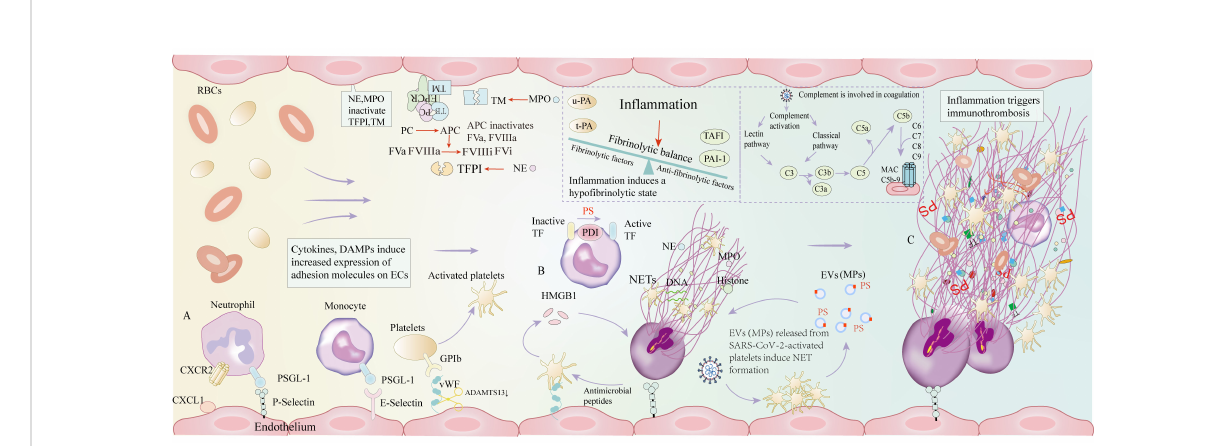
FIGURE 1 The mechanisms of immunothrombosis in COVID-19 patients. (A) In fl ammation induces immune cell recruitment and increased expression of adhesion molecules, including P-selectin, E-selectin, and vWF. (B) Activated platelets activate neutrophils and generate NETs through the release of HMGB1, and the components of NETs, antimicrobial peptides, further induce platelet activation, forming a positive feedback activation. NE and MPO can inactivate TFPI and TM, thereby inhibiting anticoagulant function. Monocytes exert pro-coagulant effects by converting inactive TF to active TF, which is required for PS and PDI. EVs (MPs) are mainly derived from SARS-CoV-2-activated platelets. Platelet-derived EVs (MPs) are responsible for robust NET formation, which plays a critical role in COVID-19 thrombosis. Activated platelets and platelet-derived EVs are markers and central mediators of COVID-19 immunothrombosis. Under in fl ammatory settings, elevated levels of thrombin-activatable fi brinolysis inhibitor and PAI-1 surpass the role of u-PA and t- PA, thereby resulting in inhibition of fi brinolysis. SARS-CoV-2 induces complement activation, which is involved in coagulation. (C) The above processes eventually cause immunothrombosis. vWF: von Willebrand factor; NETs: Neutrophil extracellular traps; HMGB1: human high mobility group protein 1; NE: Neutrophil elastase; MPO: Myeloperoxidase; TFPI: tissue factor pathway inhibitor; TM: thrombomodulin; TF: tissue factor; PS: Phosphatidylserine; PDI: Protein disul fi de isomerase; EVs: Extracellular vesicles; MPs: Microparticles; PAI-1: plasminogen activator inhibitor; u-PA: urokinase-type plasminogen activator; t-PA: tissue plasminogen activator; SARS-CoV-2: severe acute respiratory syndrome coronavirus 2; CXCL-1: chemokine (C-X-C motif) ligand 1; CXCR2: C-X-C motif chemokine receptor 2; PSGL-1: P-selectin glycoprotein